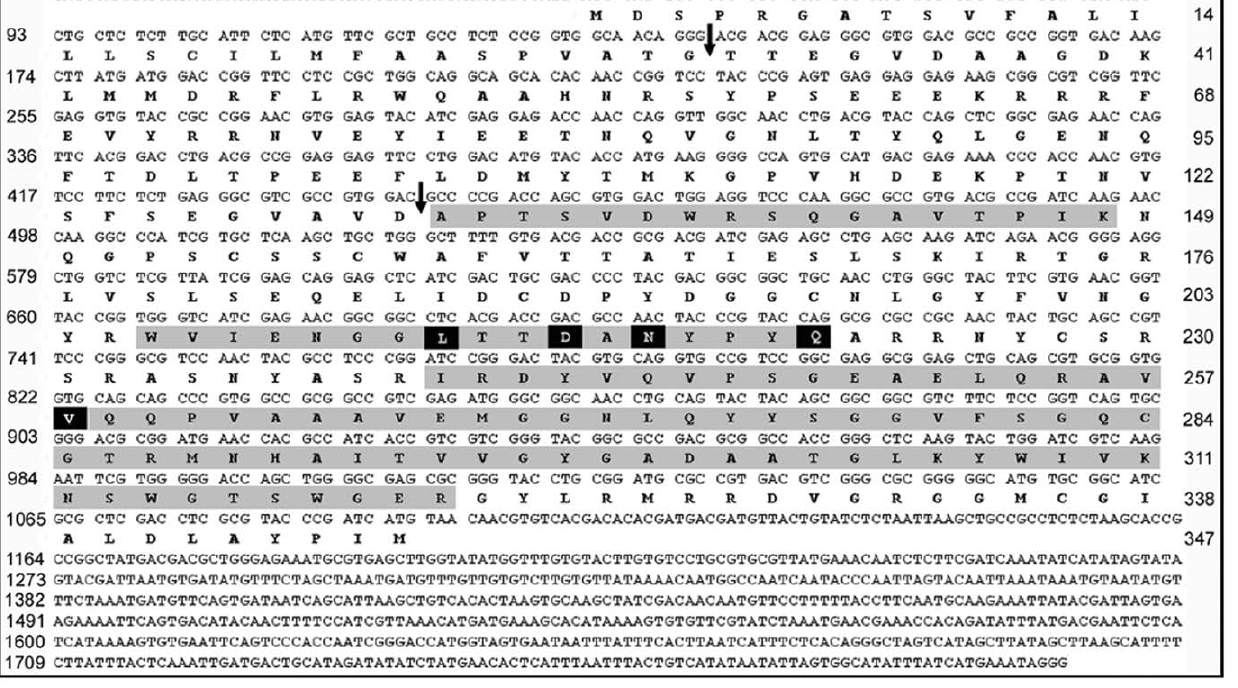
Figure 4. Cloning of the full-length cDNA and protein sequence of the BGP coat, IgE-reactive cysteine protease. The full-length cDNA sequence was cloned from Bermuda grass floral RNA. The protein sequence appears below the mRNA open reading frame. The numbers on the left indicate the nucleotide position at the beginning of each line. The numbers on the right indicate the amino-acid position at the end of each line. The arrows indicate the putative cleavage site for the signal peptide (top arrow) and the cleavage site of the pro-domain (bottom arrow). Gray shading indicates IgE-reactive band peptide sequence obtained from peptide sequencing by Edman degradation that matches the cDNA sequence. Sequences that do not match peptide-sequencing results are shaded in black.